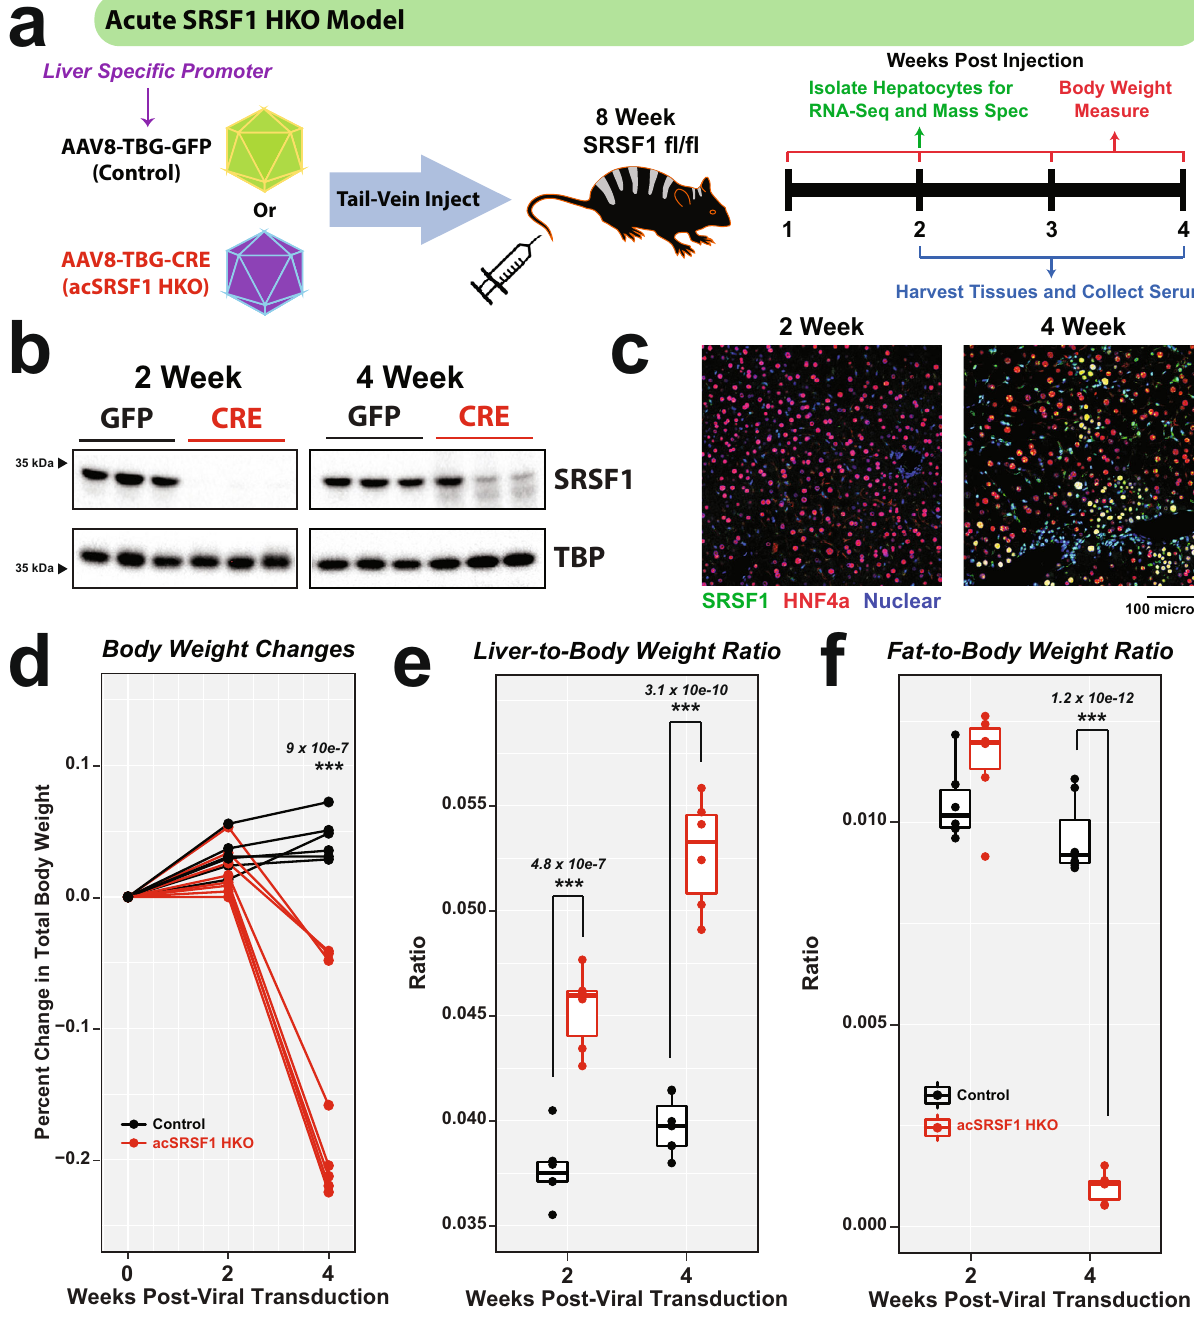
Fig.5|Generationandcharacterizationofmicewithacutehepatocyte-speci fi c knockout of SRSF1. a Schematic description of acute hepatocyte-speci fi c SRSF1 knockout (acSRSF1 HKO) mice model and experimental design. Transgene expression is driven by the liver-speci fi c thyroxine-binding globulin (TBG) pro- moter. b Western blot showing hepatic SRSF1 protein levels in acSRSF1 HKO (CRE) relative to controls (GFP) at the indicated timepoints post viral transduction. TBP served as a loading control. c Representative IF images of liver sections from acSRSF1HKOmiceatindicatedtimepoints( n =5biologicallyindependentanimals, 6 fi eldsper replicate). IFimagesshowco-staining withSRSF1 (green),HNF4 α (red),